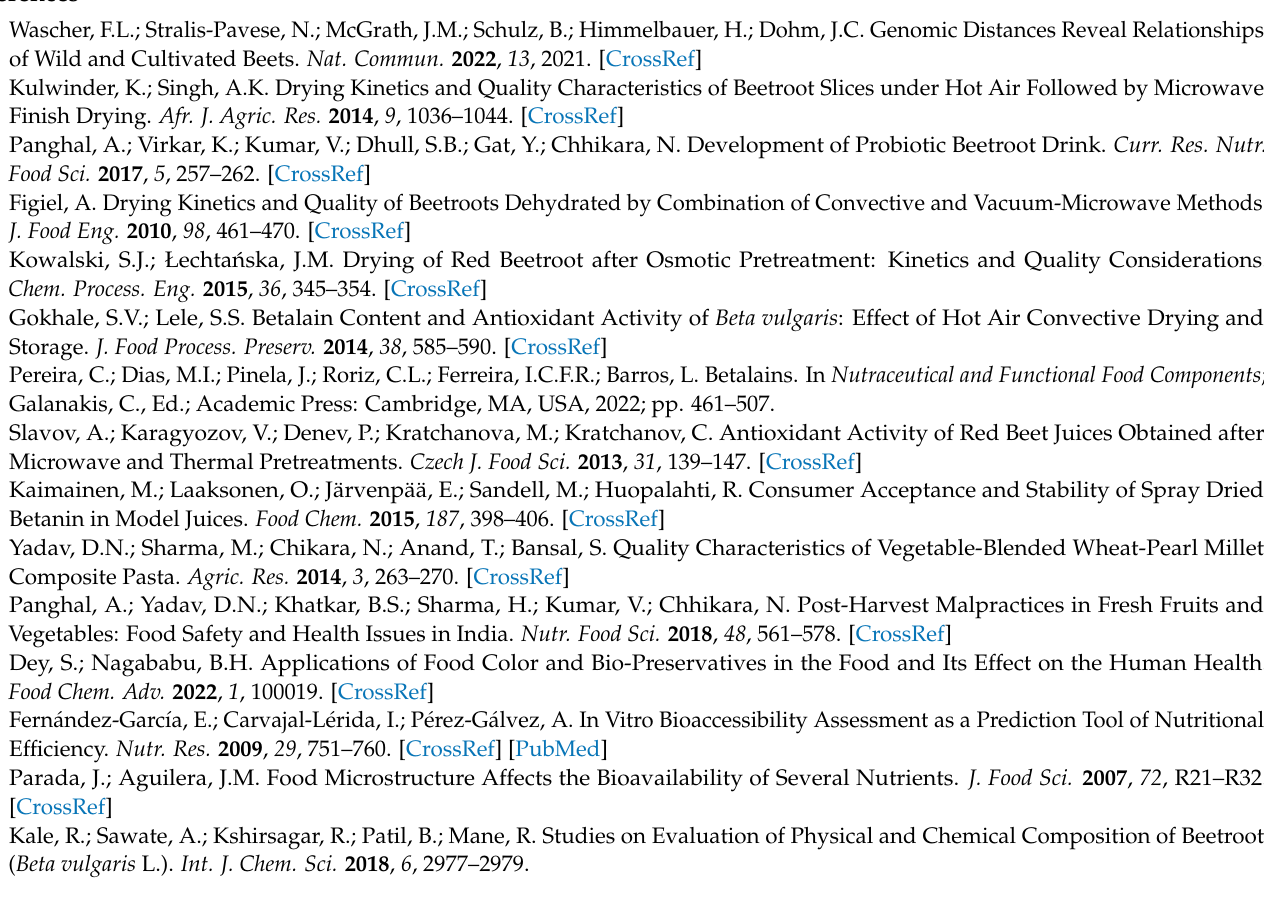
Figure S2: Maximum UV-vis absorption spectrum (recorded at 215 nm) of oxalic acid (A), quinic acid (B), and malic acid (D). Figure S3: UFLC organic acid profile of beetroot (A), gastric phase (B), intestinal phase (C), and digested (D) sample, recorded at 215 nm. Peak identification: 1- oxalic acid; 2-quinic acid; and 3-malic acid; Figure S4: HPLC chromatographic profile of betacyanins in beetroot (A), gastric phase (B), intestinal phase (C), and digested (D) sample recorded at 535 nm. Peak identification: 1-betanidin-5- O -glucoside (betanin); 2-isobetanidin-5- O -glucoside (isobetanin); and 3-14,15-dehydrobetanin (neobetanin); Figure S5: Maximum absorption spectrum (recorded at 535 nm) and mass spectrum (full MS and MS 2 ), obtained by HPLC-DAD-ESI/MS n , of the three beta- cyanins identified in the beetroot samples. Peak identification: 1-betanidin-5- O -glucoside (betanin); 2-isobetanidin-5- O -glucoside (isobetanin); and 3-14,15-dehydrobetanin